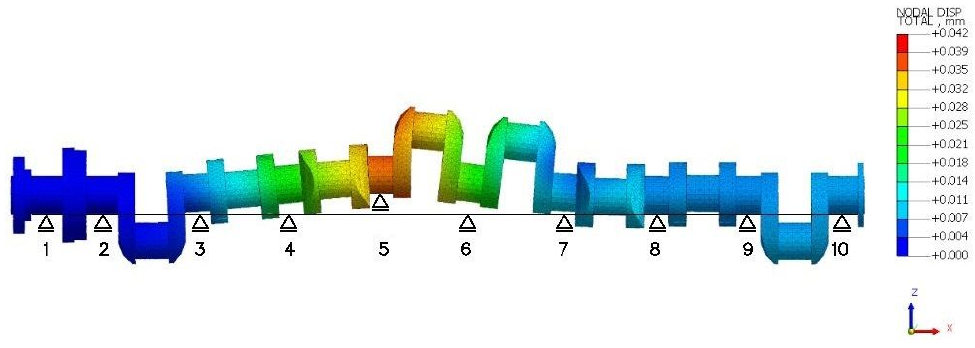
Figure 17. Crankshaft deformations in the case where one of the supports (supporting journal No. 5) is displaced upwards in relation to the others.